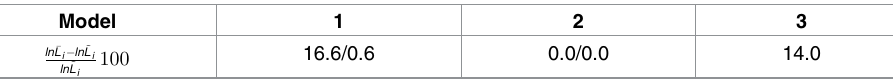
Table 11. Percentage of improvement in